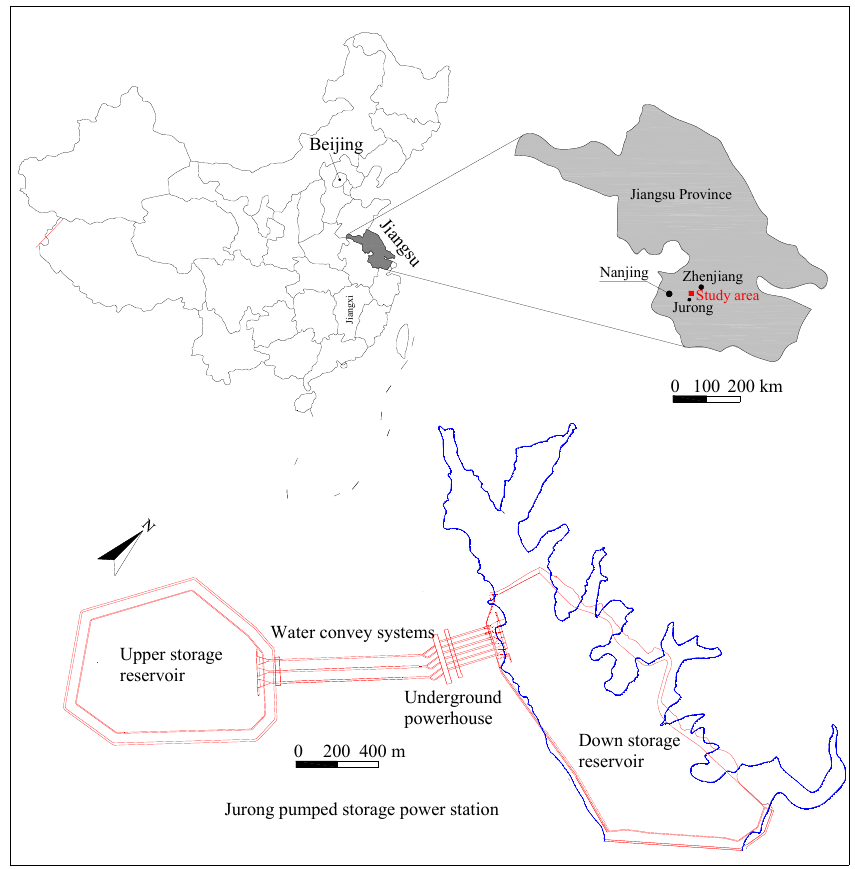
Figure 1. Location of study area.